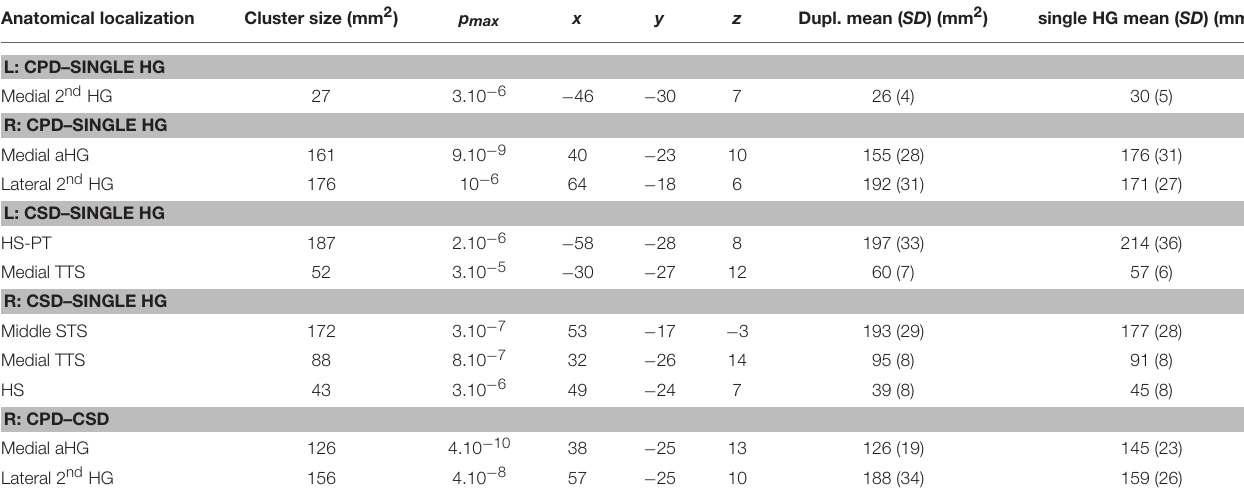
TABLE 2 | Local variations of Cortical Surface Area (CSA) detected in “CPD–single HG”, “CSD–single HG,” and “CPD–CSD” contrasts. Anatomical